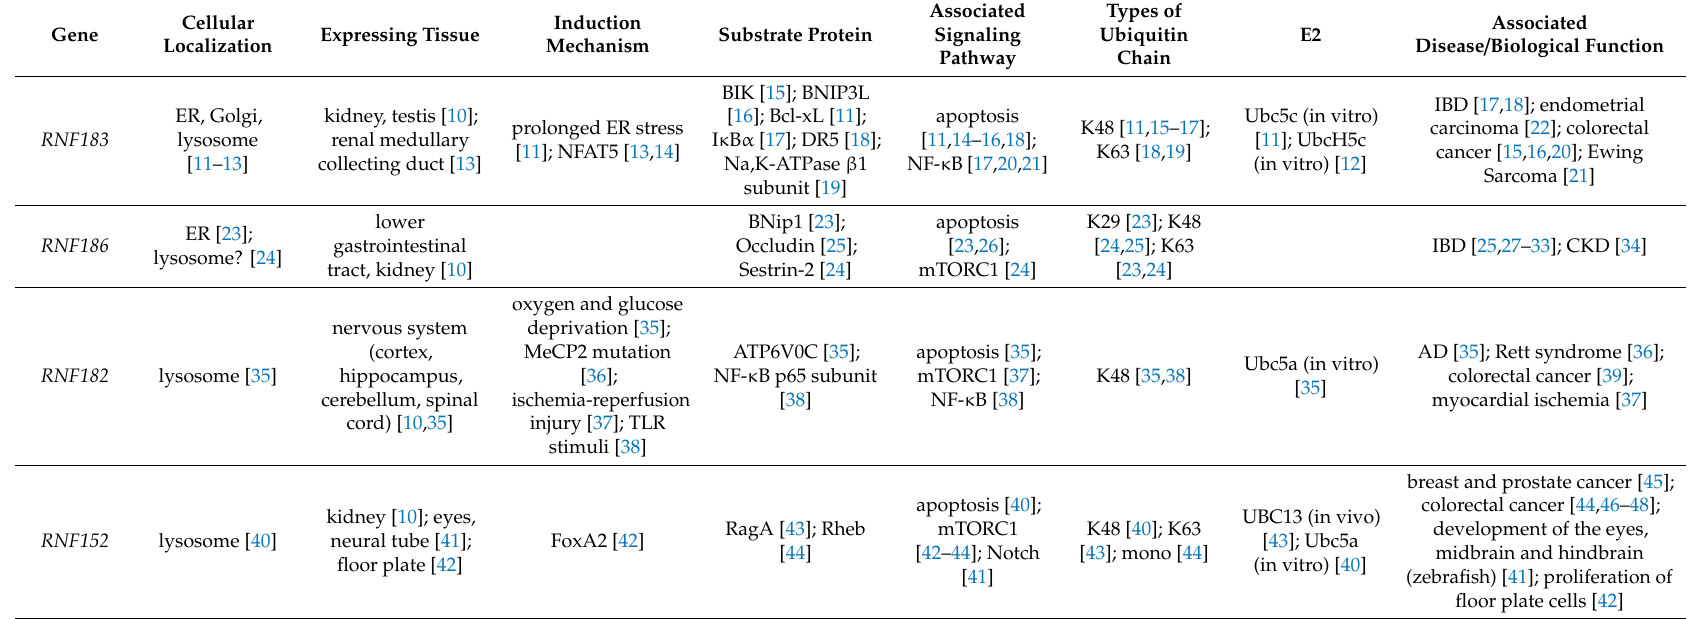
Table 1. Features of RNF183